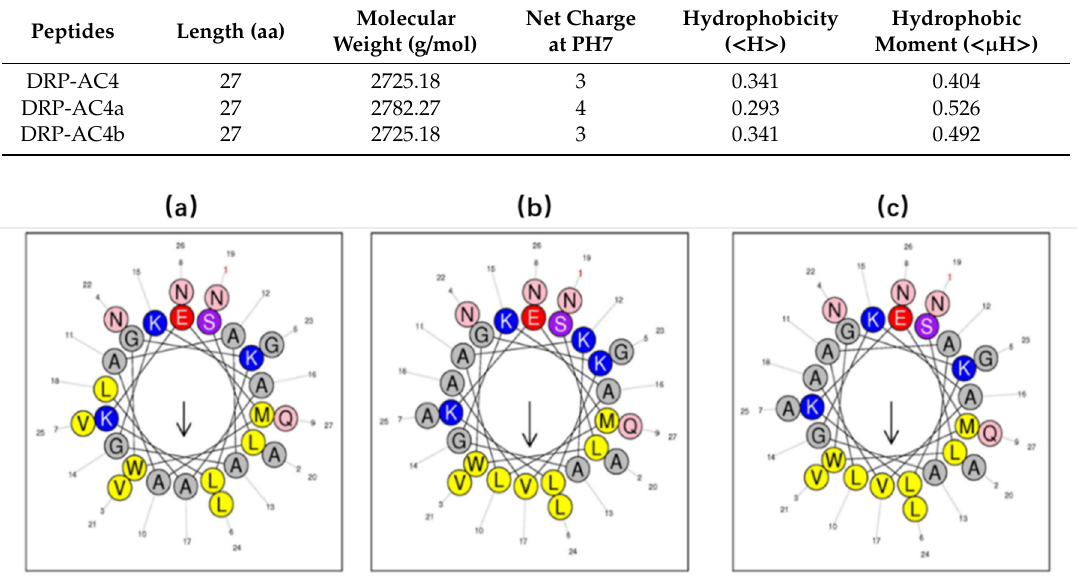
Table 2. Amino acid sequences and calculated of α -helix proportion of DRP-AC4, DRP-AC4a and